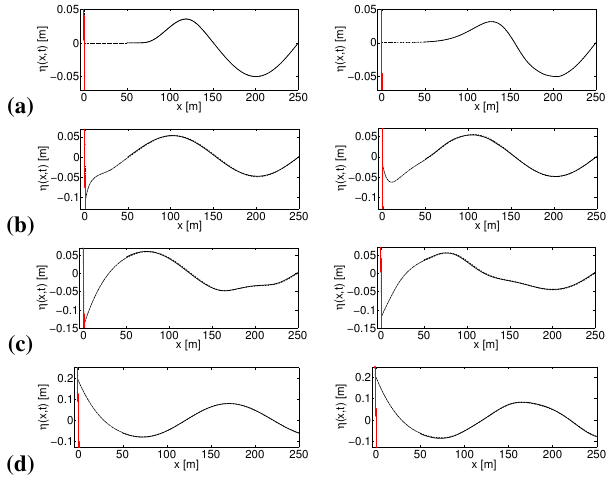
Fig. 11. The shoreline movement of periodic waves for the linear model ( a : LSWE, b : LVBM) coupled to the NSWE (dashed line) and for the linear model with an EBC implementation (solid line). Paths of the first-order characteristic curves are shown by the thin lines.